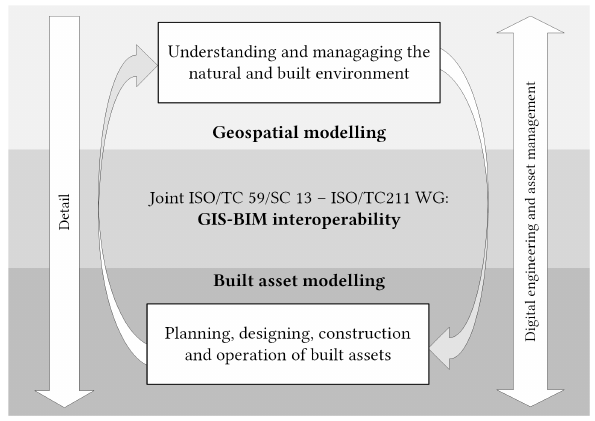
Figure 1. The idealized schematic information cycle demonstrates the need for BIM/GIS interoperability. Figure adopted from (ISO 23262,